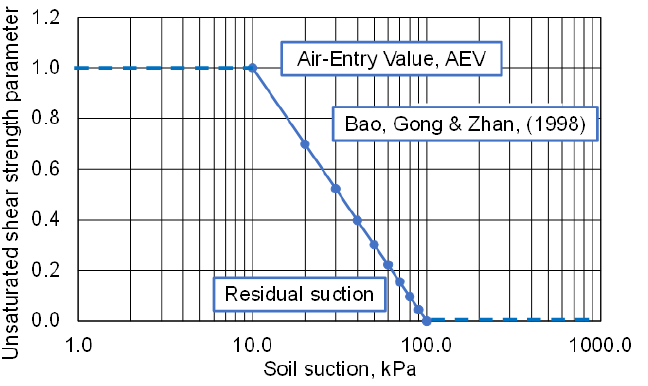
Figure 22. Unsaturated shear strength function proposed by Bao, Gong and Zhan [30].